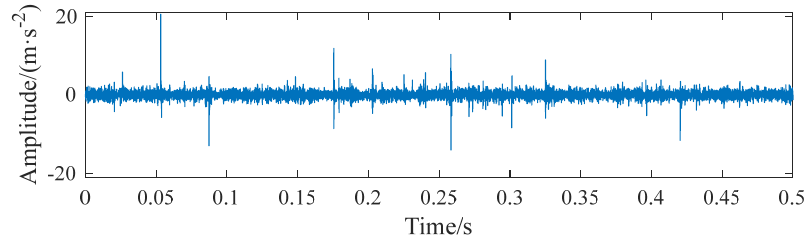
Figure 12. The waveform of the 2056th set of data.